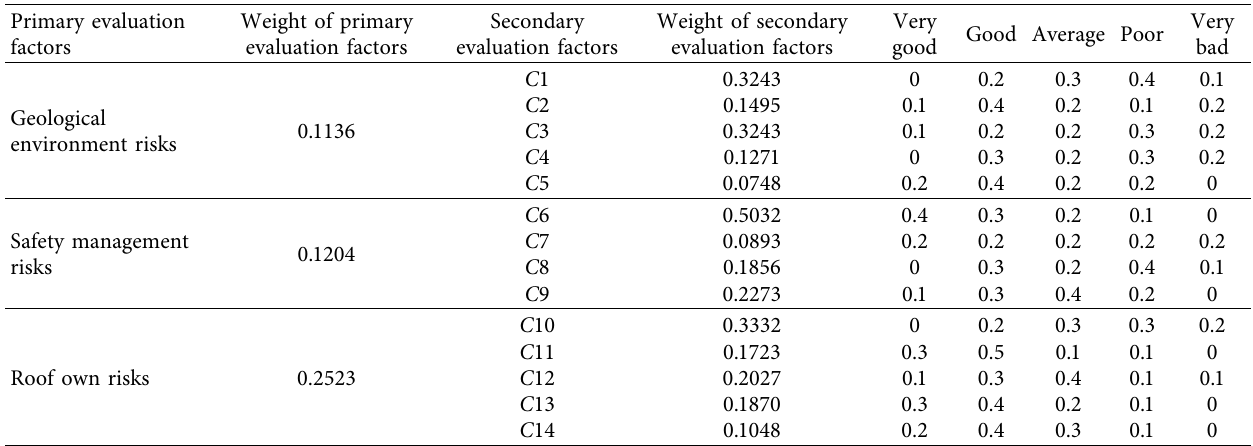
Table 11: Scoring statistics of weights and expert safety grades.